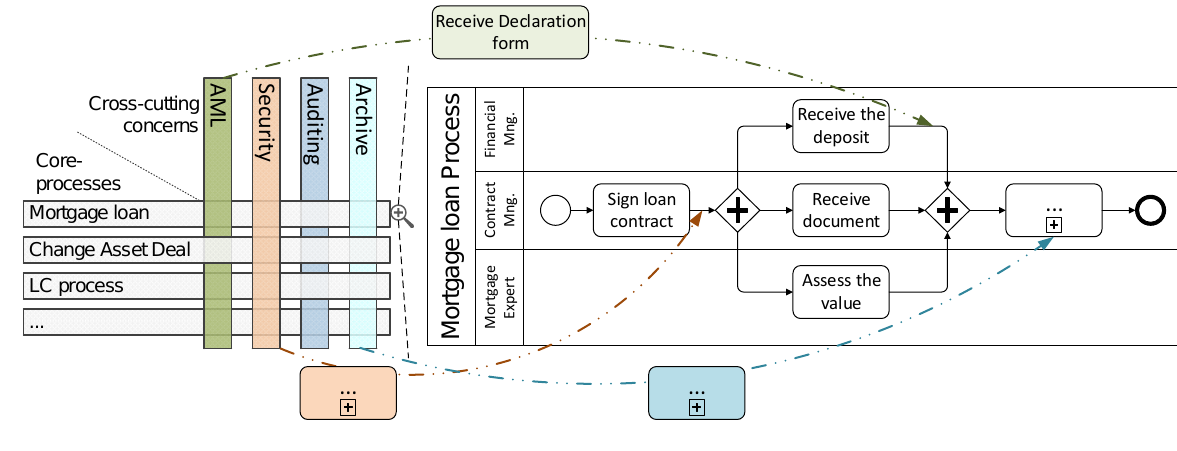
Figure 1. The Motivating Example [1]